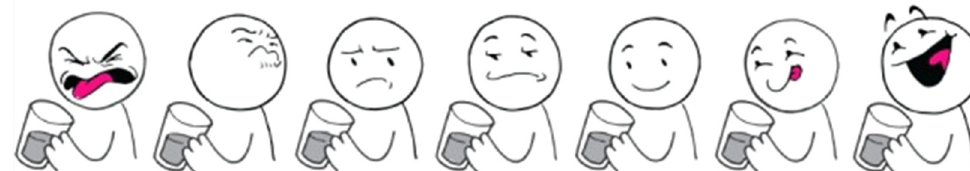
Figure 1. Seven facial children expression presented to estimate taste acceptance: TASTY scale